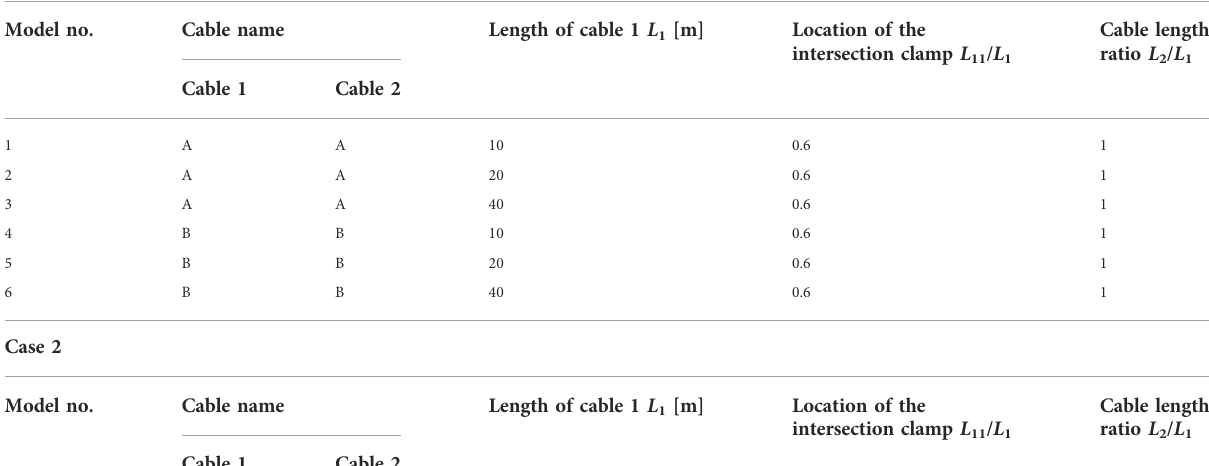
TABLE 3 Models of two cables with intersection clamp considered in numerical veri fi cations. Case